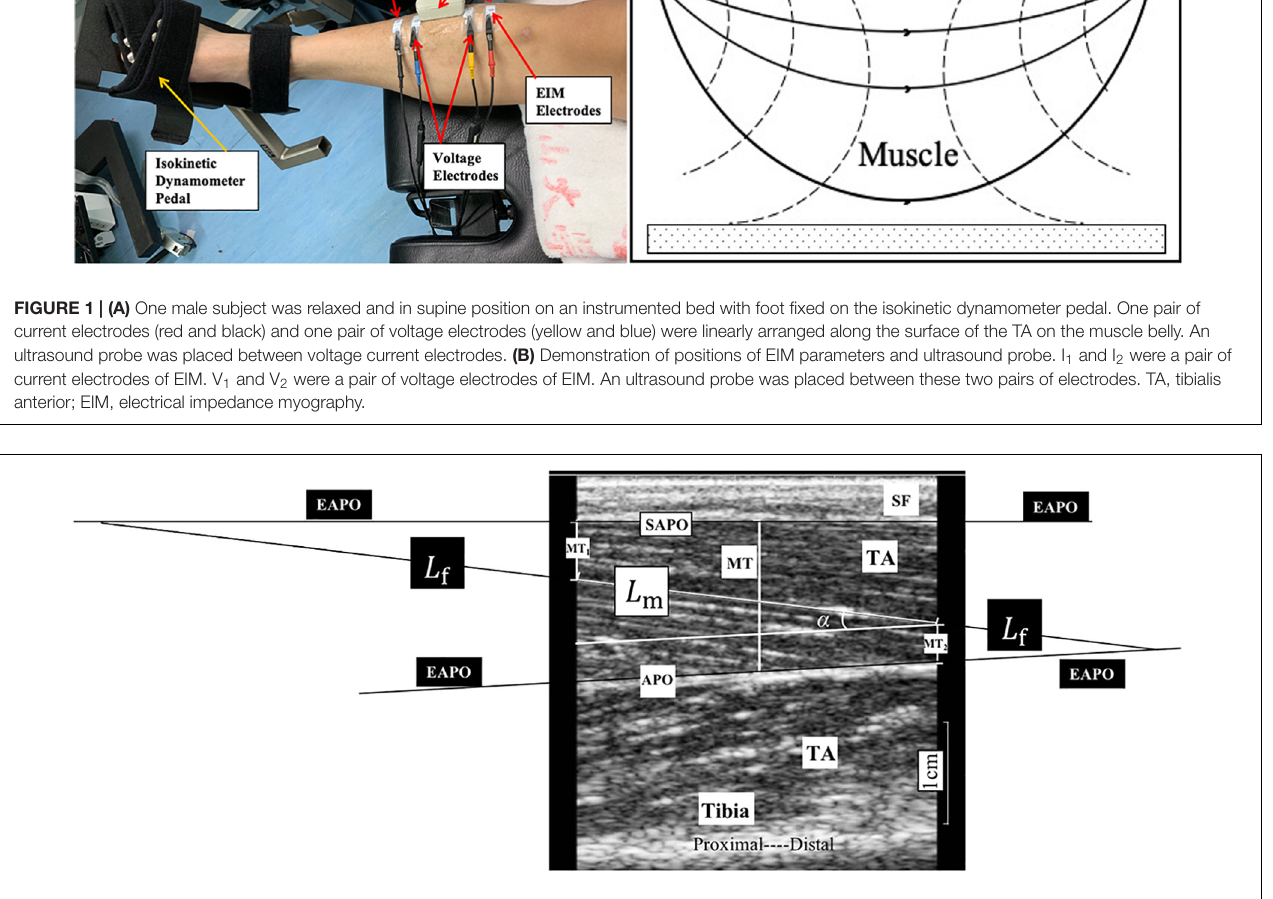
FIGURE 2 | A typical ultrasonography image of non-paretic tibialis anterior (TA) from a participant during assessment. MT 1 and MT 2 are the distance of the visible fiber distal end point to the superficial aponeurosis and the distance of the visible fiber proximal end to the aponeurosis, respectively; and α is the pennation angle (PA). We considered the middle thickness of captured image as the muscle thickness (MT) of the TA, so we measured, respectively, the thickness of both left and right edges of the TA in the image and take the average value of these two measurements as MT for statistical analysis. APO, aponeurosis; EAPO, extension of